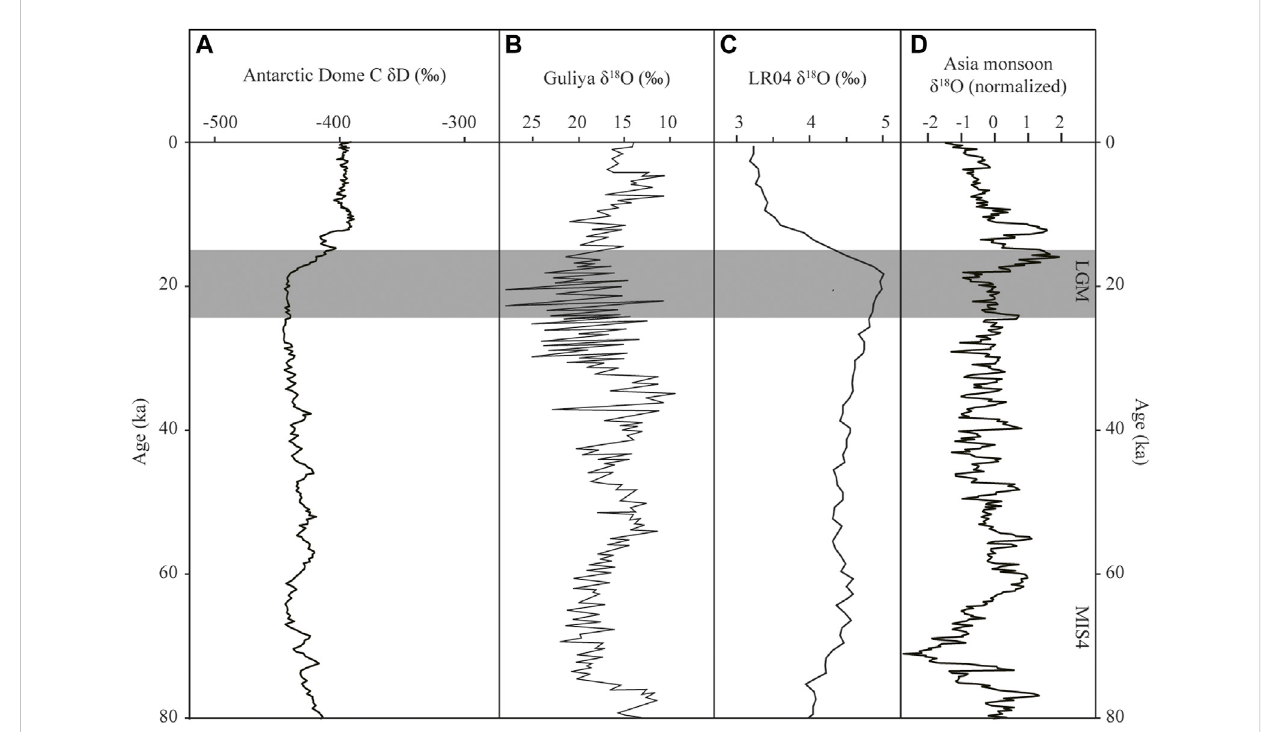
FIGURE 7 (A) δ DrecordoftheAntarcticDomeCicecore(EPICACommunityMembers,2004). (B) δ 18 OrecordoftheGuliyaicecore(modi fi